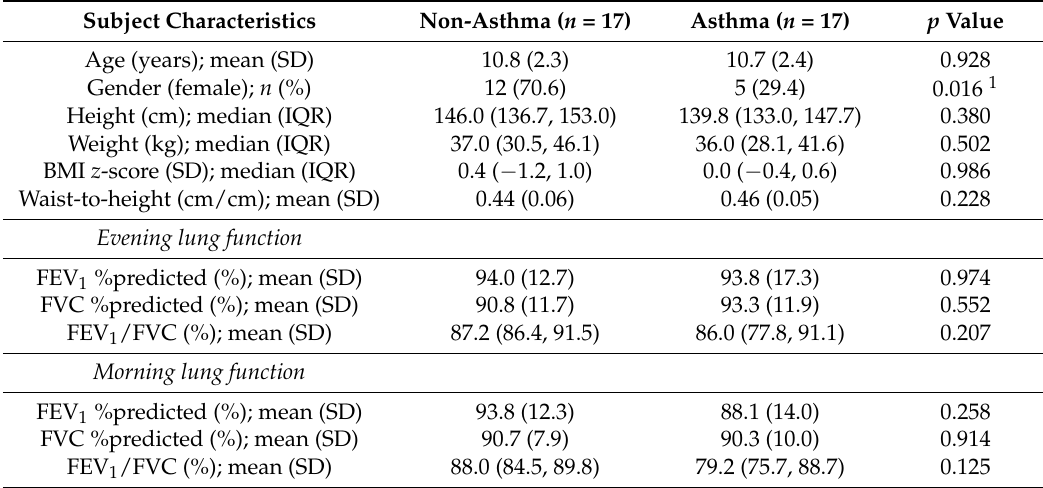
Table 1. Subject characteristics and lung function of children with and without asthma, referred for an overnight